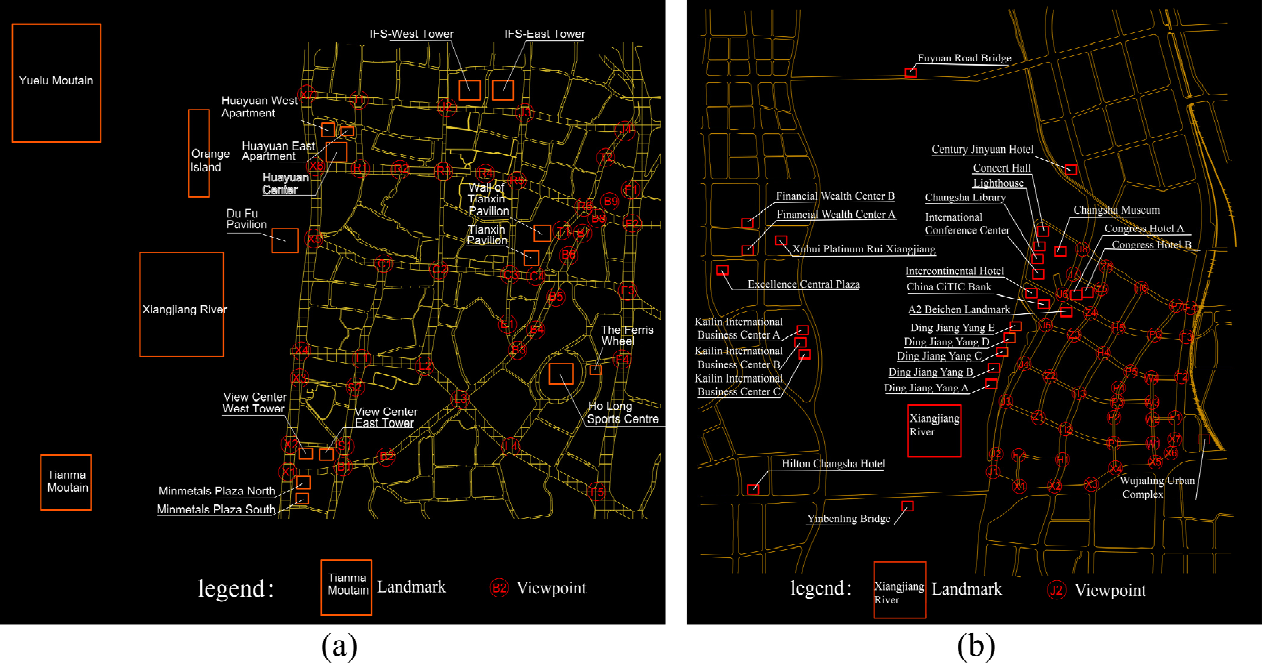
Figure 12. Route decision nodes and landmarks on area streets. ( a ) TP-District; ( b ) XD-District.